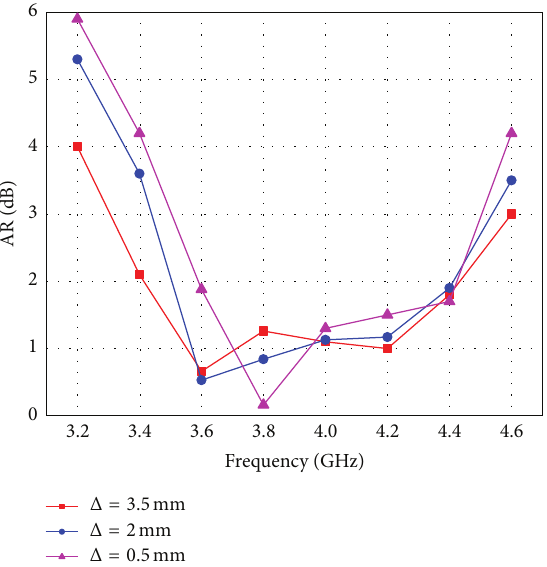
Figure 3: Effect of parameter Δ on antenna